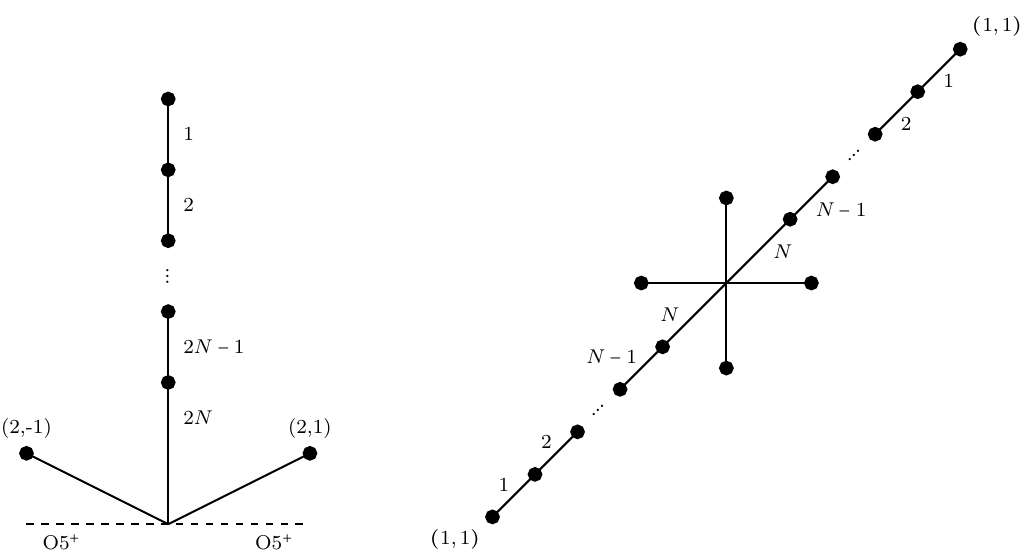
Figure 2. Brane webs engineering EQ 1 , 3 (left) and EQ 3 (right). For the unitary brane web engineering EQ 1 , see figure